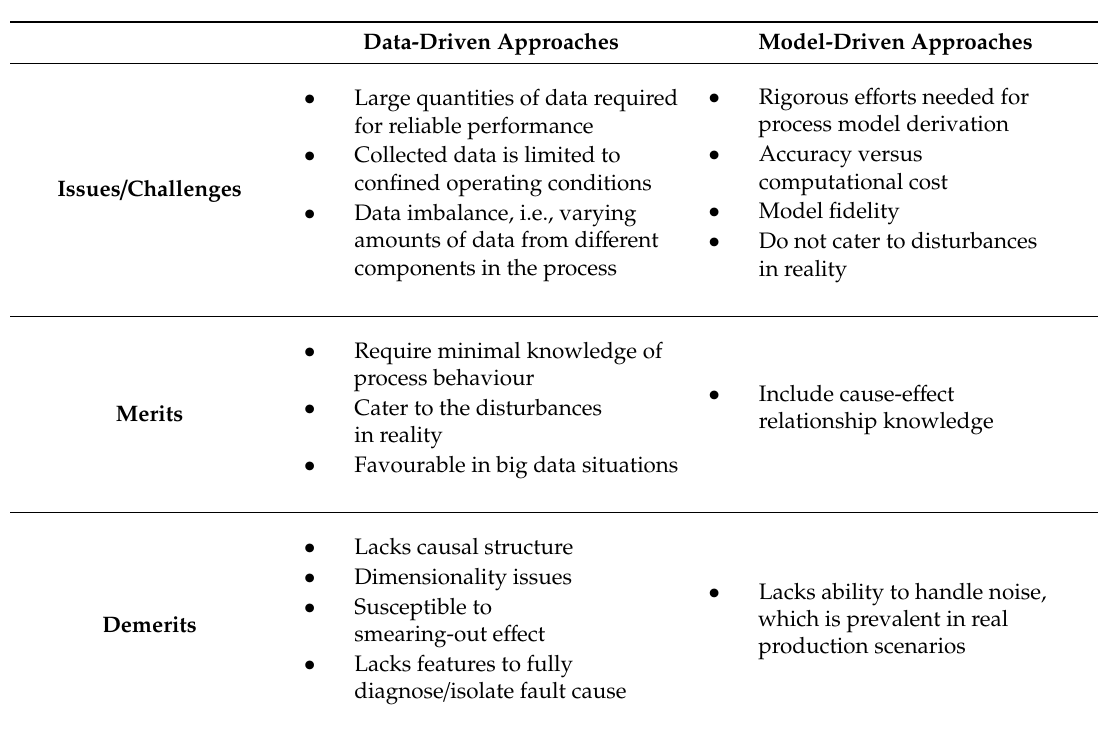
Table 1. Summary of identified challenges of prevalent methods in the context of process monitoring and